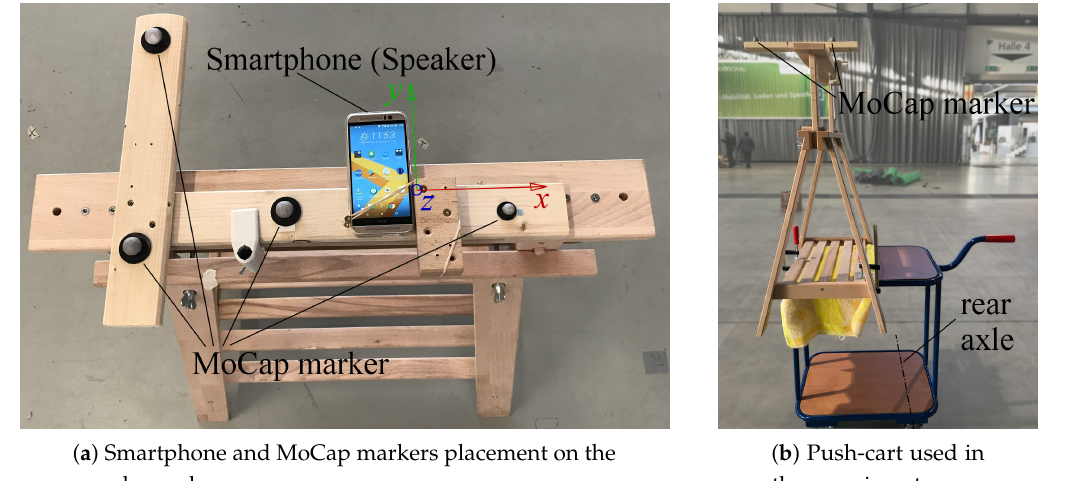
the experiments.